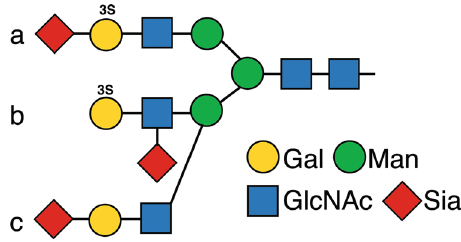
Fig. 7 Theoretical combinations of terminal 3-O-sulfated galactose and sialic acid. Potential relationships of a , b , and c of 3-O-SGal and sialylation of N-glycans, as discussed in the